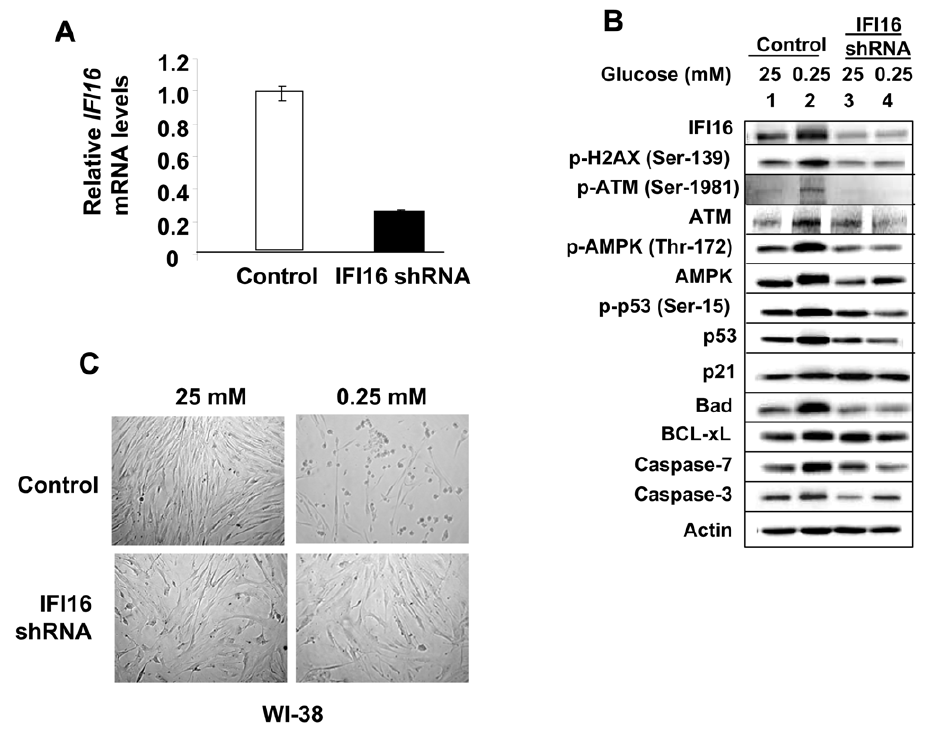
Figure 5. The expression of IFI16 protein is required for the activation of the ATM/AMPK/p53 pathway in response to glucose restriction. ( A ) Total RNA isolated from WI-38 HDFs either infected with control or IFI16 shRNA lentivirus particles was subjected cDNA synthesis, followed by quantitative real-time PCR using the TaqMan assay for the IFI16 gene. ( B ) Sub-confluent cultures of young WI-38 HDFs either infected with control (Vector) or IFI16 shRNA lentivirus particles (shIFI16) were incubated with the indicated concentrations (mM) of glucose in the medium supplemented with 10% fetal bovine serum for 18 h. At the end of the incubations, cells were lysed and equal amounts of proteins were analyzed by immunoblotting using antibodies specific to the indicated proteins. ( C ) Sub-confluent cultures of young WI-38 HDFs either infected with control (top panel) or IFI16 shRNA lentivirus particles (lower panel) were incubated with the indicated concentrations (mM) of glucose in the medium supplemented with 10% fetal bovine serum for 18 h. At the end of the incubations, cells were photographed using a phase contrast microscope.